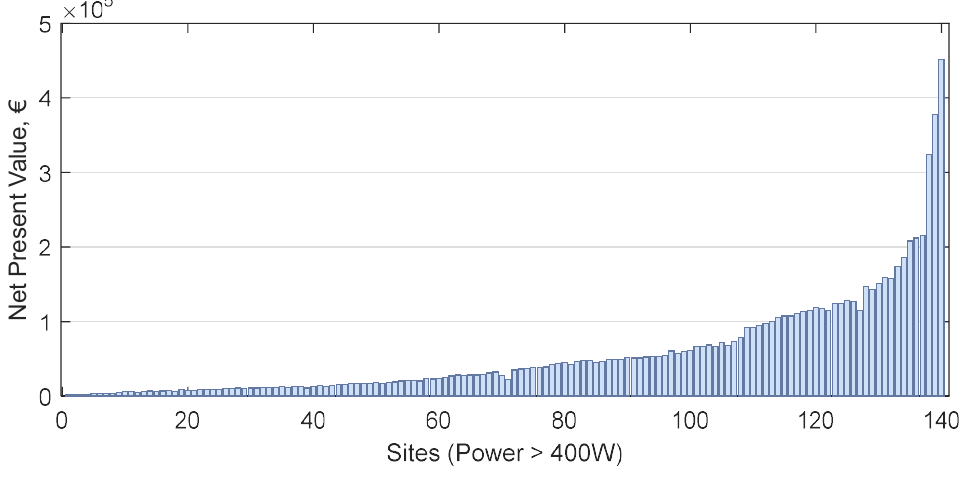
Figure 12. Net present value in the evaluated sites considering that the PAT represents 26% of the total installation cost.